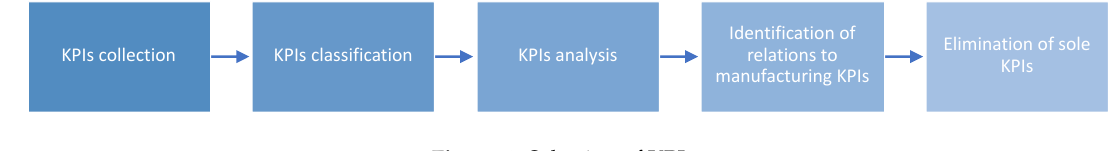
Figure 3. Social KPIs.